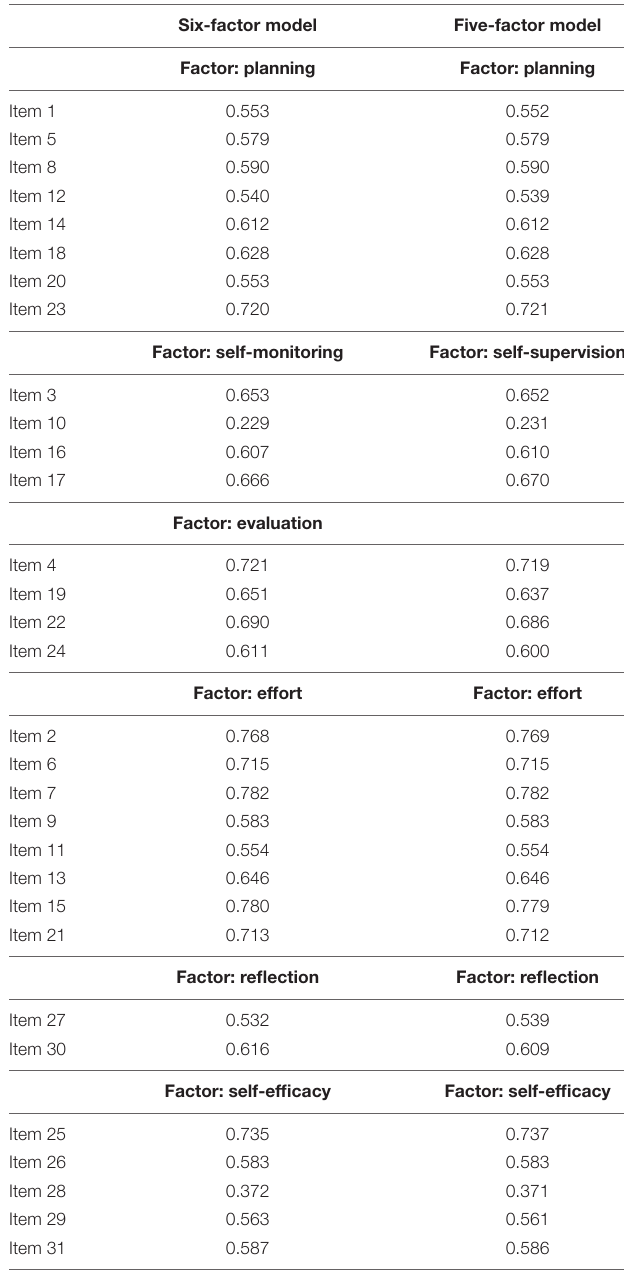
TABLE 2 | Standardized factor loading of the 31 items of the SRL-SRS for Sport Practice for the six-factor model and the five-factor